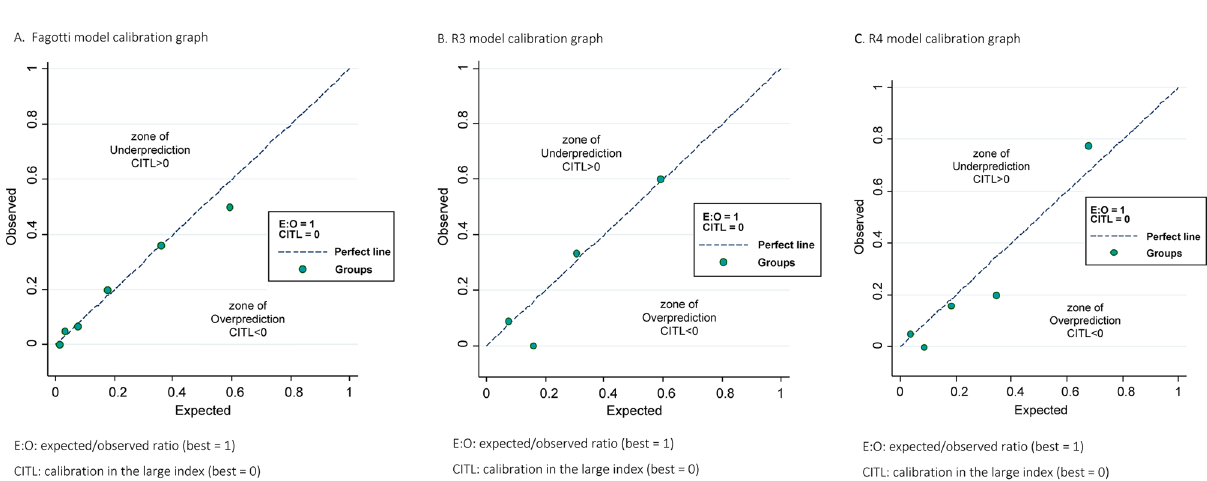
Figure 1. Calibration plots for suboptimal cytoreduction by probability groups ( A ) Fagotti model calibration graph. E:O: expected/observed ratio (best = 1), CITL: calibration in the large index (best = 0). ( B ) R3 model calibration graph. E:O: expected/observed ratio (best = 1). CITL: calibration in the large index (best = 0). ( C ) R4 model calibration graph. E:O: expected/observed ratio (best = 1). CITL: calibration in the large index (best = 0).